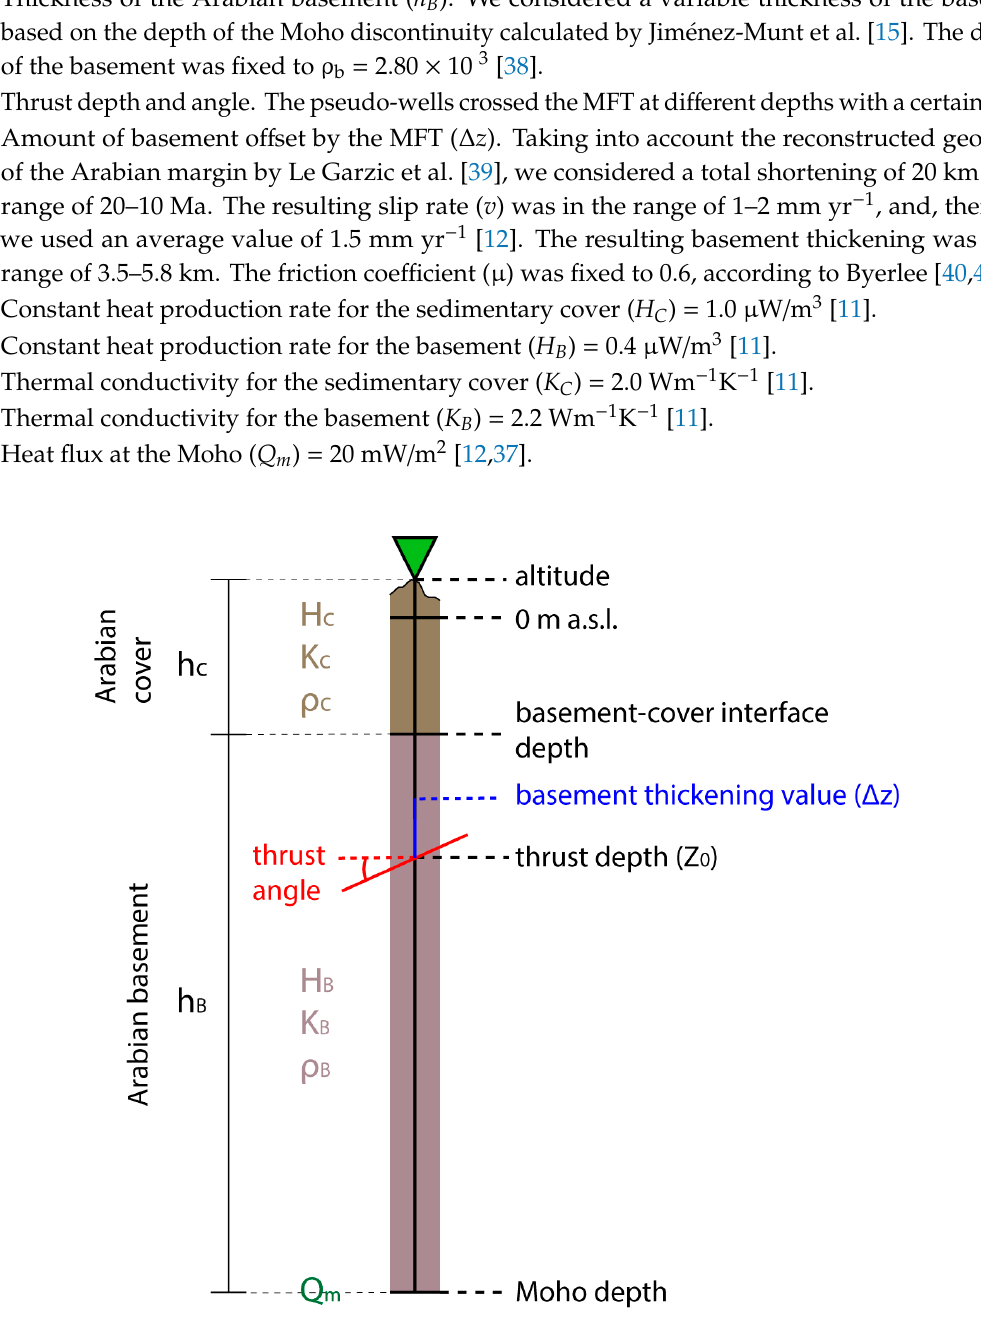
Figure 6. Schematic representation of the different components included in the analytical geotherm calculation along one of the pseudo-wells of Figure 5. H C and H B are heat production rates for sedimentary cover and basement, respectively; Q m is heat flux at Moho; K C and K B are thermal conductivity for the sedimentary cover and basement, respectively; ρ c and ρ b are density of the sedimentary cover and basement, respectively.